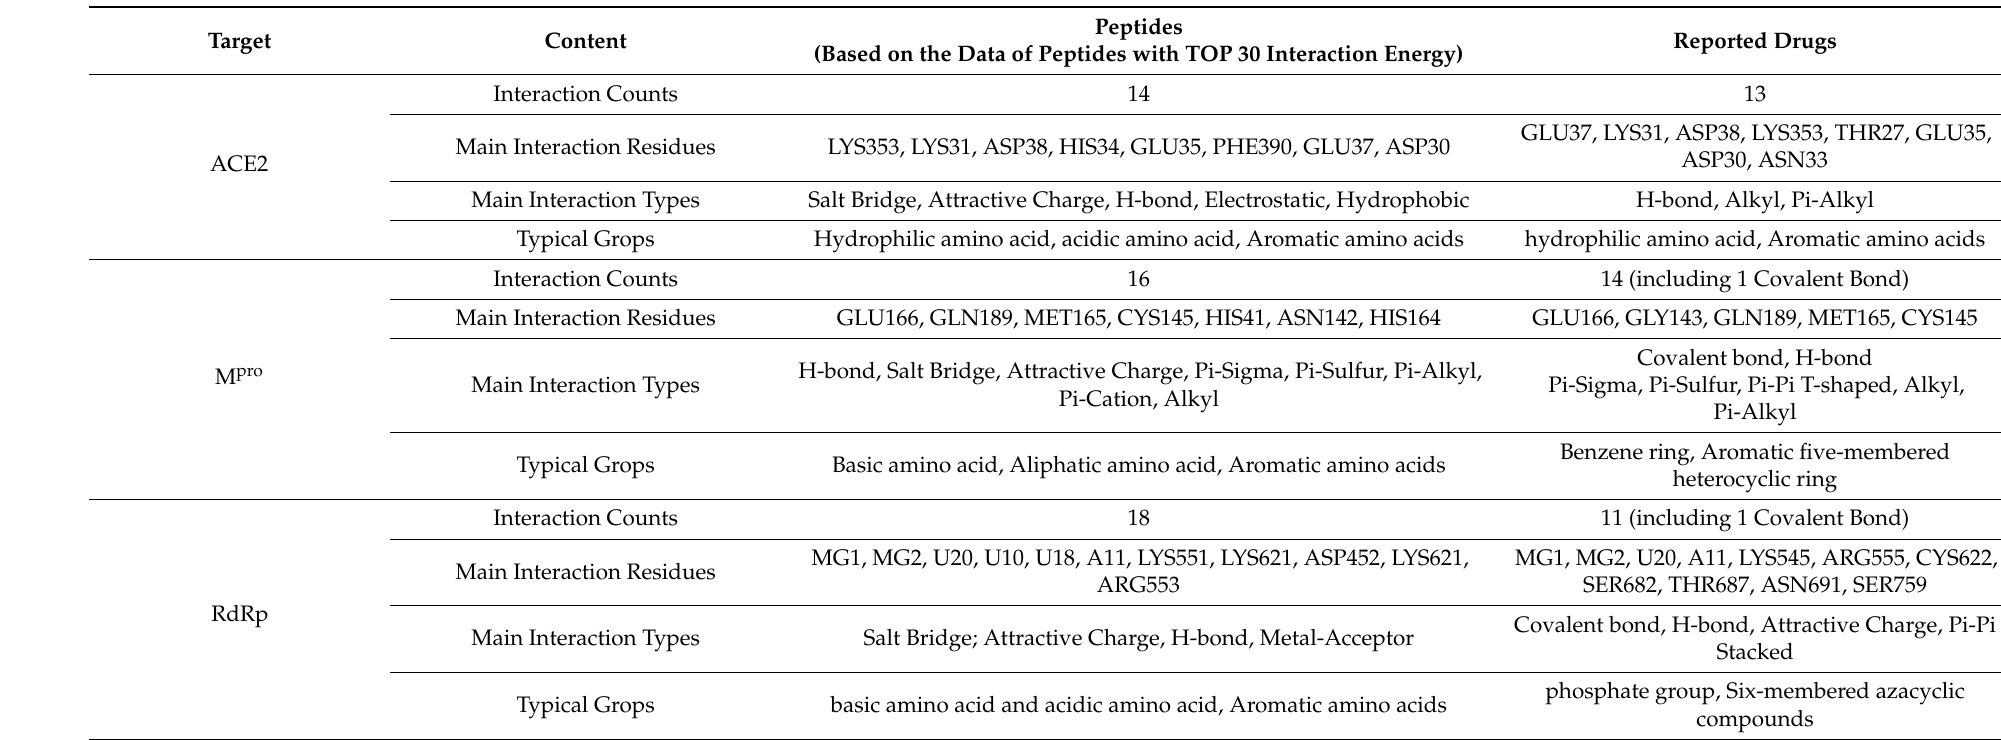
Table 3. The summary for the peptides with potential high inhibitory activity comparing with reported drugs (molecular docking simulation